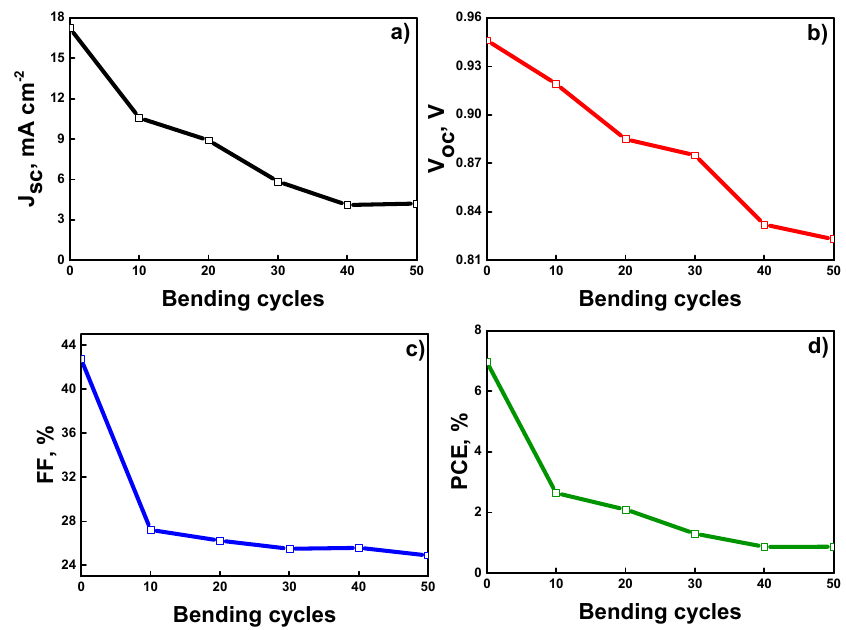
Figure 9. Variation in the ( a ) J sc , ( b ) V oc , ( c ) FF, and ( d ) PCE of the device upon bending.